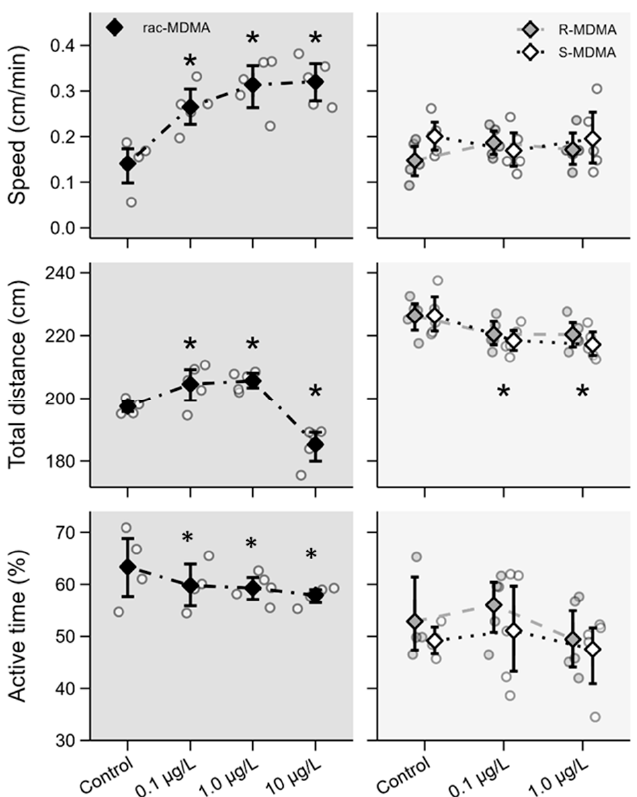
Figure 5. Behavioural effects of ( R,S )-MDMA ( left ; dark grey panels) and its enantiomers ( right ; light grey panels) determined on day 5 in Daphnia magna . Data are presented as individual observations (circles), mean values (diamonds) and 95% bootstrap confidence intervals (error bars). Asterisks (*) represent significant differences relative to the control.